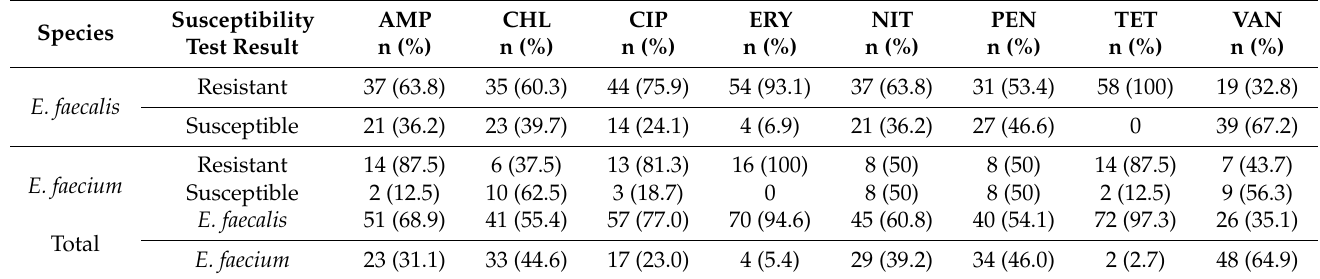
Table 4. Antimicrobial Susceptibility Profiles of Enterococcus faecalis and Enterococcus faecium